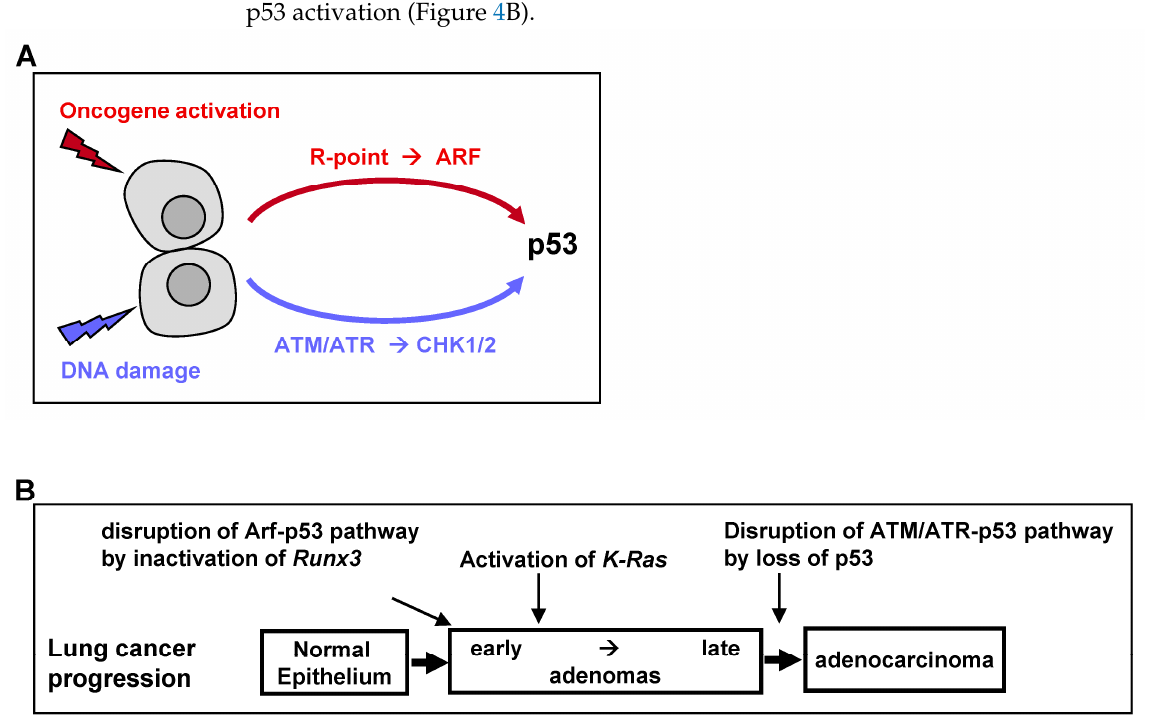
Figure 4. Inactivation of p53 tumor suppressor pathways. ( A ) Two major pathways trigger p53 activation. Aberrant oncogene activation is sensed by the R-point-associated complex, which induces the expression of ARF , inactivating HDM2 and stabilizing p53. DNA damage stress is sensed by the ATM/ATR kinases, activating the CHK1/CHK2 kinases, which stabilize p53. ( B ) Inactivation of p53 tumor suppressor pathways during multistep tumor progression. AD development is characterized by disruption of the Arf-p53 pathway due to the abrogation of the R-point, most frequently by RU3 inactivation. This may result in the selection of K-Ras -activated cells, which acquire a proliferative advantage. At the AD stage, the ATM/ATR → CHK1/2 → p53 pathway is functional. The pathway is disrupted at a late stage of AD by p53 mutation.